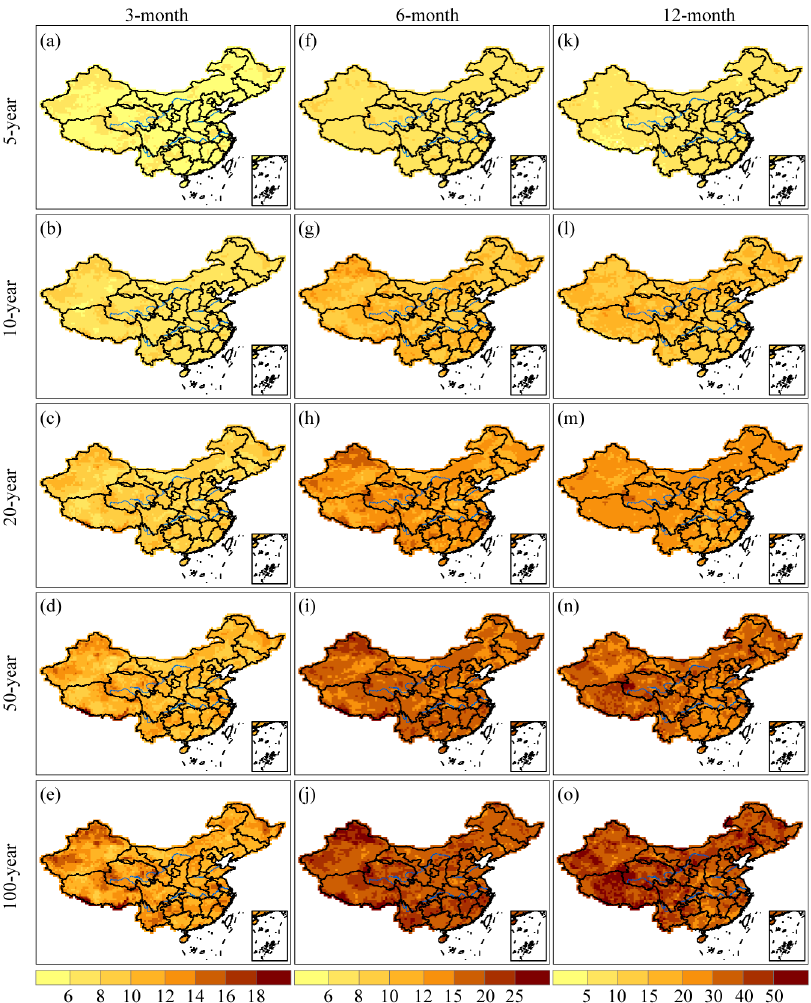
Figure 4. Spatial distributions of drought severity with 5-, 10-, 20-, 50-, and 100-year return periods based on SPI-3, SPI-6, and SPI-12 values. Specifically, ( a – e ) in each panel show the spatial patterns of drought severity with return periods of 5-, 10-, 20-, 50-, and 100-year at the 3-month time scale; ( f – j ) in each panel depict the corresponding patterns at the 6-month time scale; and ( k – o ) in each panel illustrate the patterns at the 12-month time scale.